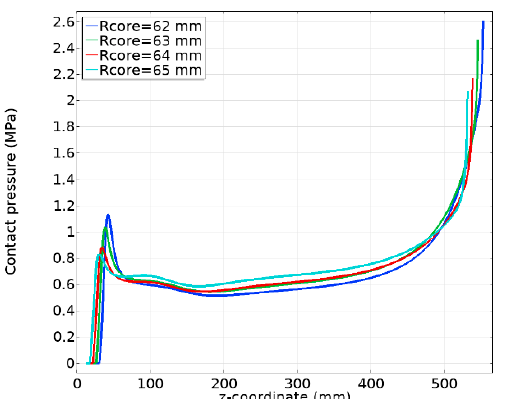
Figure 14. Contact pressure distribution between the stress cone and the cable core in the optimized design. The total spring force is controlled at 30 kN for each curve.